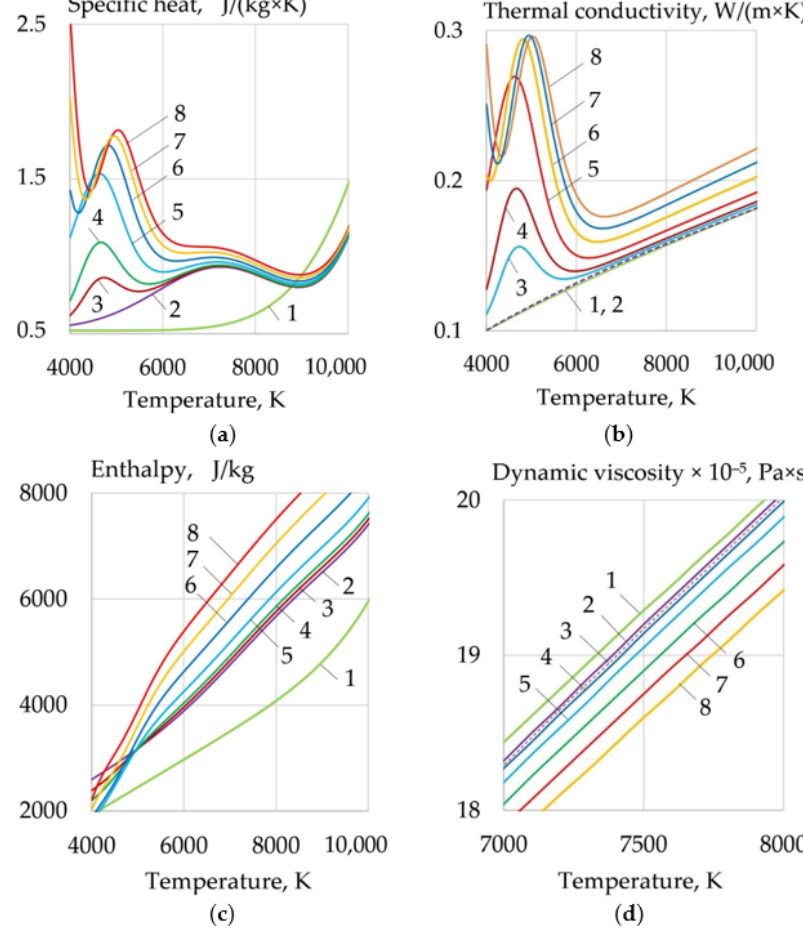
Figure 8. Change in specific heat ( a ), thermal conductivity ( b ), enthalpy ( c ), and dynamic viscosity ( d ) of an equilibrium system at 0.1 MPa, wt.%: (1) 100Ar; (2) 95Ar + 5Al; (3) 94Ar + 5Al + 1SF 6 ; (4) 93Ar + 5Al + 2SF 6 ; (5) 90Ar + 5Al + 5SF 6 ; (6) 85Ar + 5Al + 10SF 6 ; (7) 80Ar + 5Al + 15SF 6 ; (8) 75Ar + 5Al + 20SF 6 .